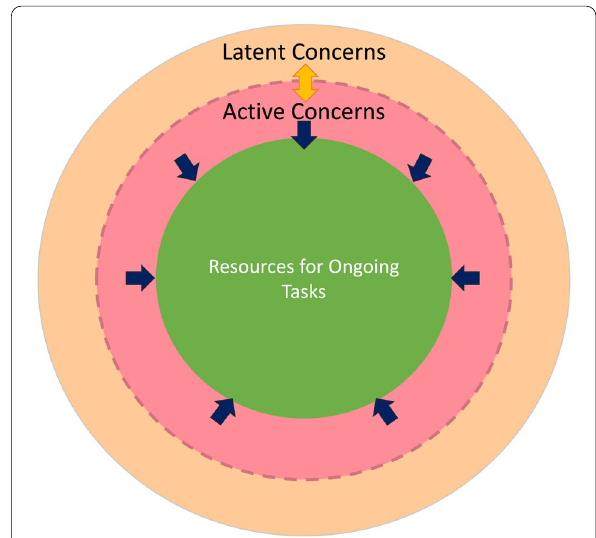
Fig. 5 A schematic illustration of the resource contraction theory. Concerns may be latent (orange) or active (pink). Active concerns lead to a reduction in attention to cognitive tasks. Current concerns disproportionately influence tasks that require internal attention (e.g., cognitive control) compared with tasks that rely on external attention (e.g., visual